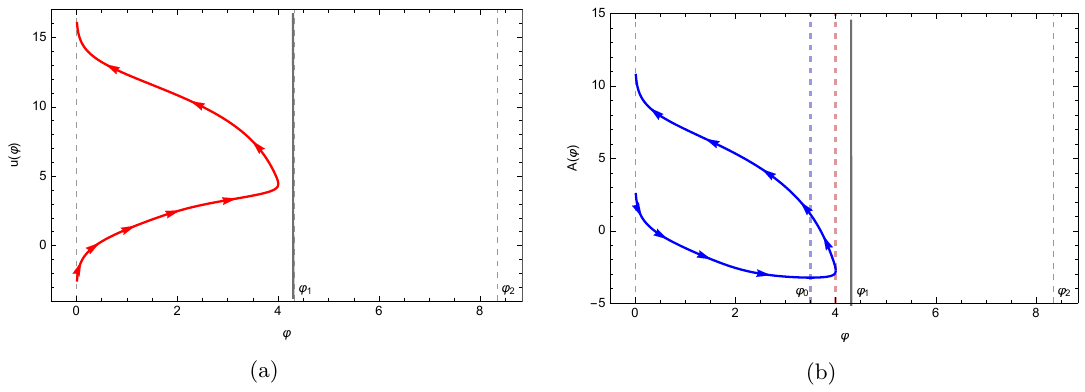
Figure 17 . (a): the holographic coordinate at top UV L tends to −∞ and at bottom UV L to + ∞ . (b): the scale factor has an A-bounce at ϕ = 3 . 5 (blue dashed line) and a ϕ -bounce at ϕ = 4 . 0 (red 0 dashed line).